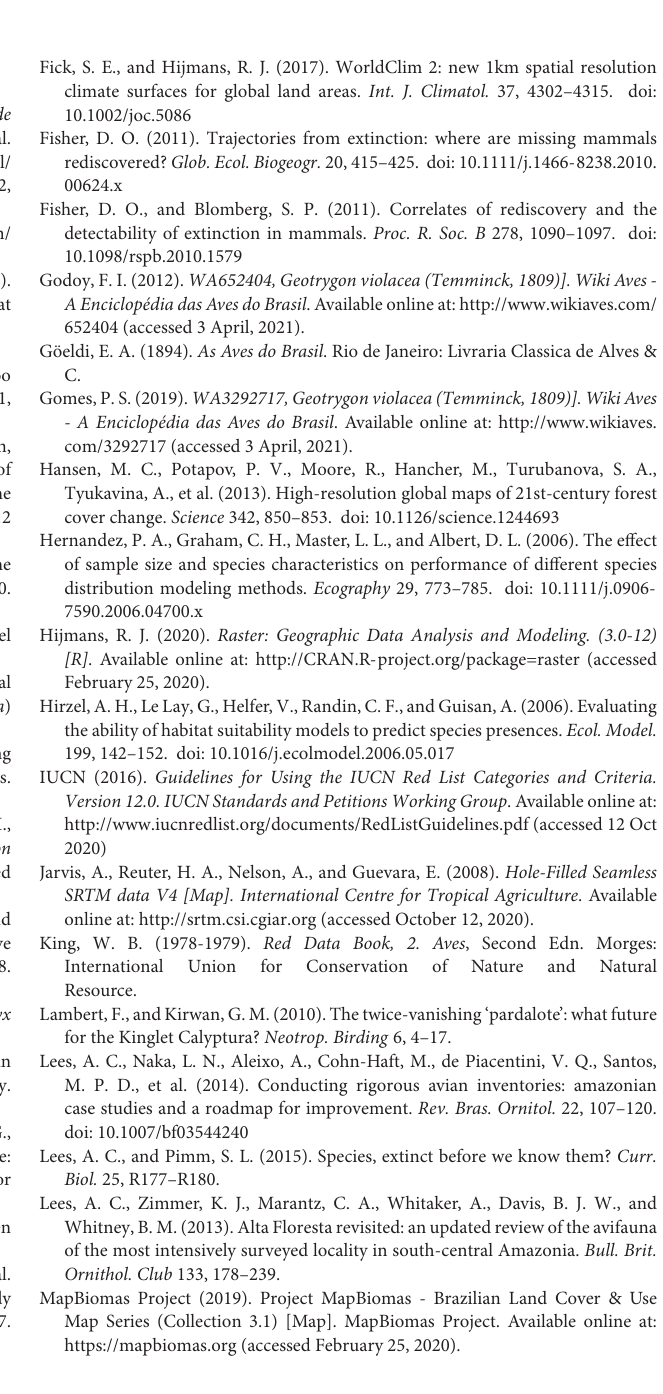
Supplementary Table 3 | Field survey input data to calculate the extinction probability of Purple-winged Ground Dove Paraclaravis geoffroyi using the method provided by Thompson et al. (2017). Supplementary Table 6 | Accession numbers and metadata for rich media deposited at the Macaulay